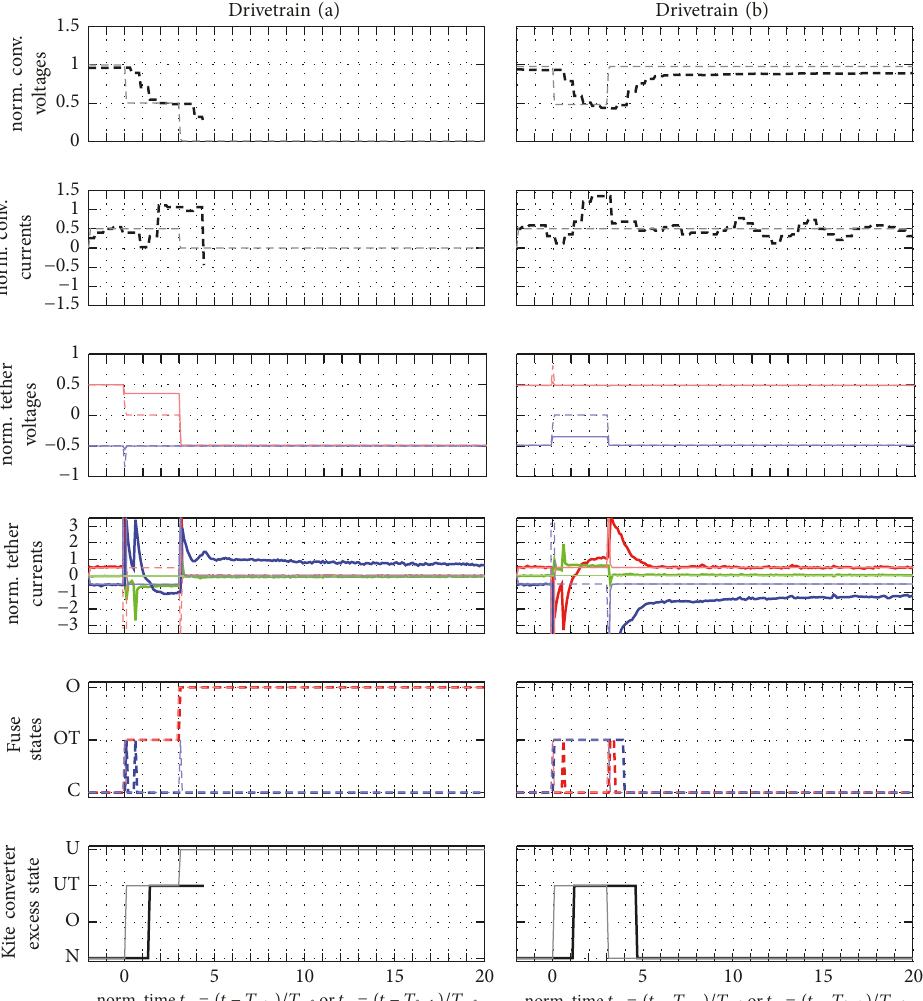
Figure 27: Measured (bold) and simulated (thin and light) voltages, currents, and states for short circuit fault S7 in motor mode, with the same colors as in Figure 18. For the measurements, the time is normalized 𝑡 instead of to the fault time 𝑇 as for the simulation fault